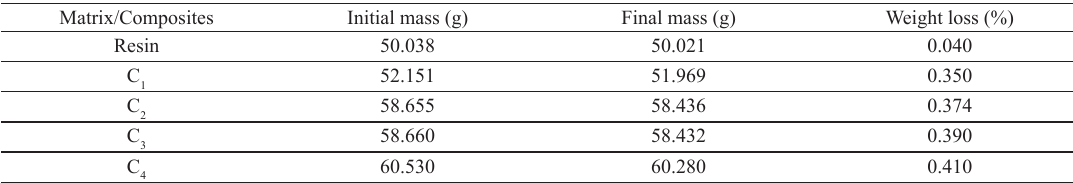
Table 7. Results of the mass variation of the aging tests for the composites and the polyester resin.